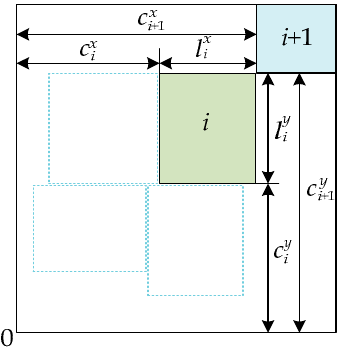
Figure 8. The example of coordinates.